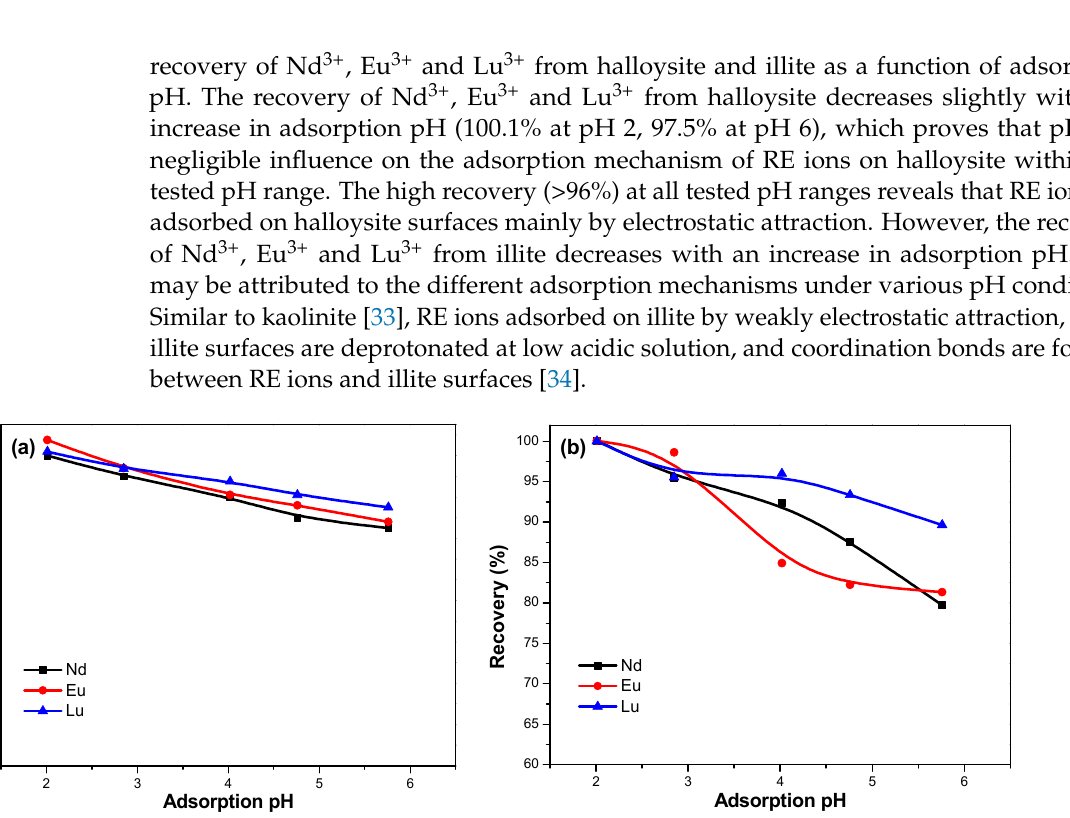
Figure 9. Effect of adsorption pH on the recovery of Nd 3+ , Eu 3+ and Lu 3+ from halloysite ( a ) and illite ( b ). (pH = 4.2, contact time = 240 min, (NH 4 ) 2 SO 4 concentration = 0.11